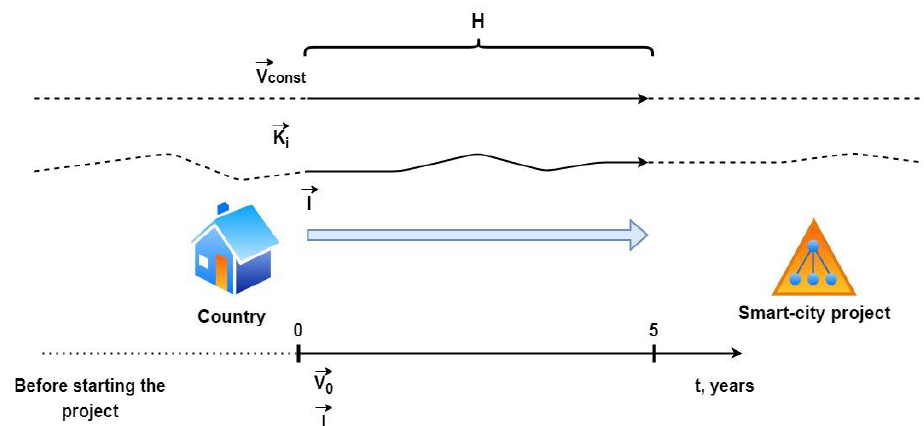
Figure 9. Variable interactions within a smart city project outcome determination. Source: made by authors.